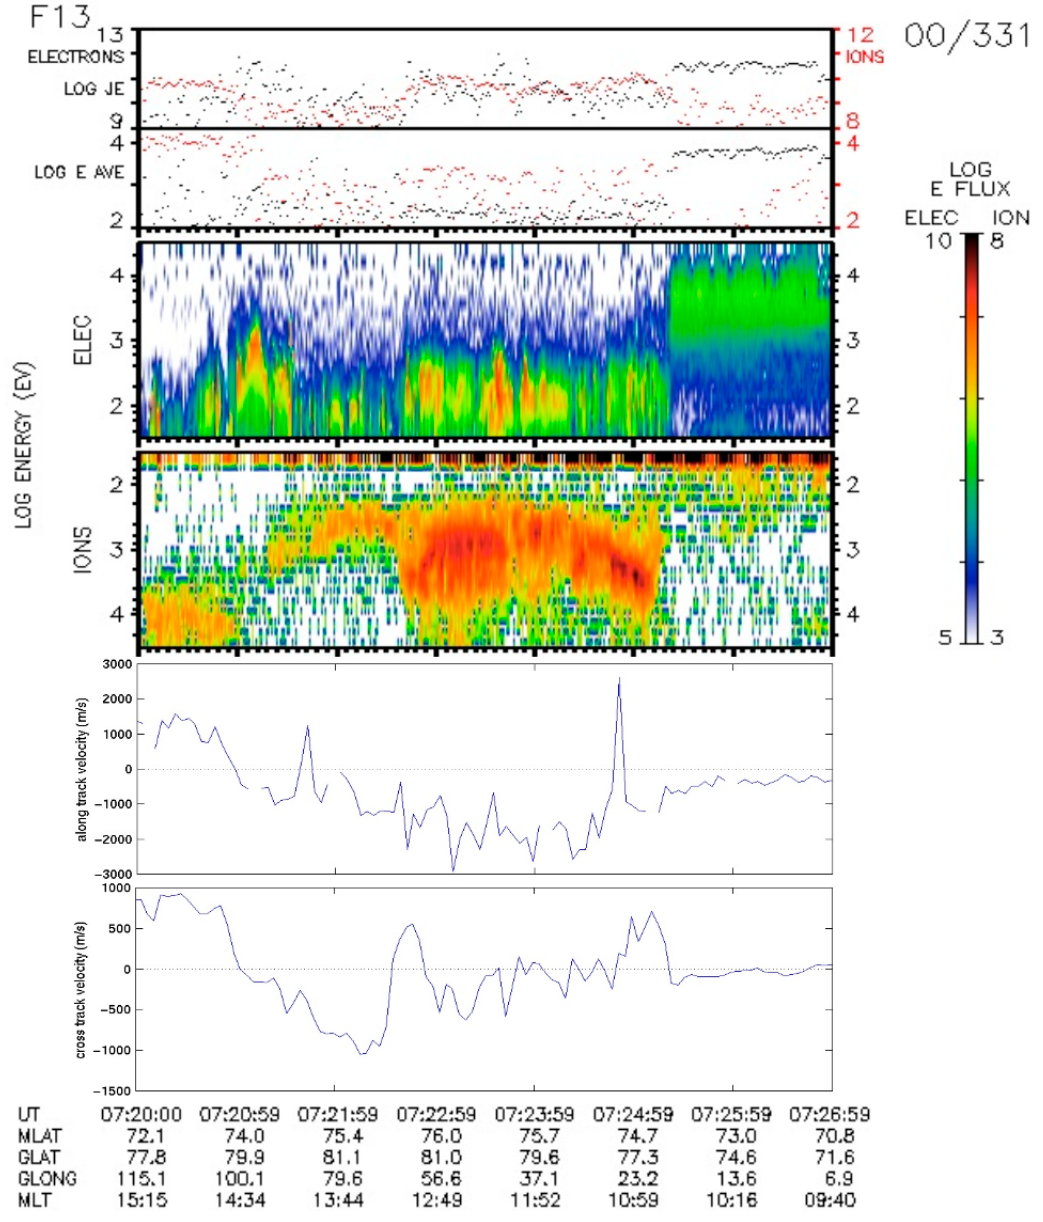
Fig. 5. Ion and electron data from SSJ/4 instrument on board DMSP-F13